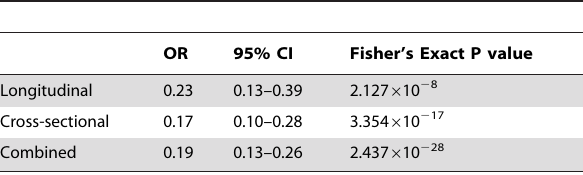
Table 3. Odds ratios for the protective effect of the rs231778 G allele in African Americans with RA.